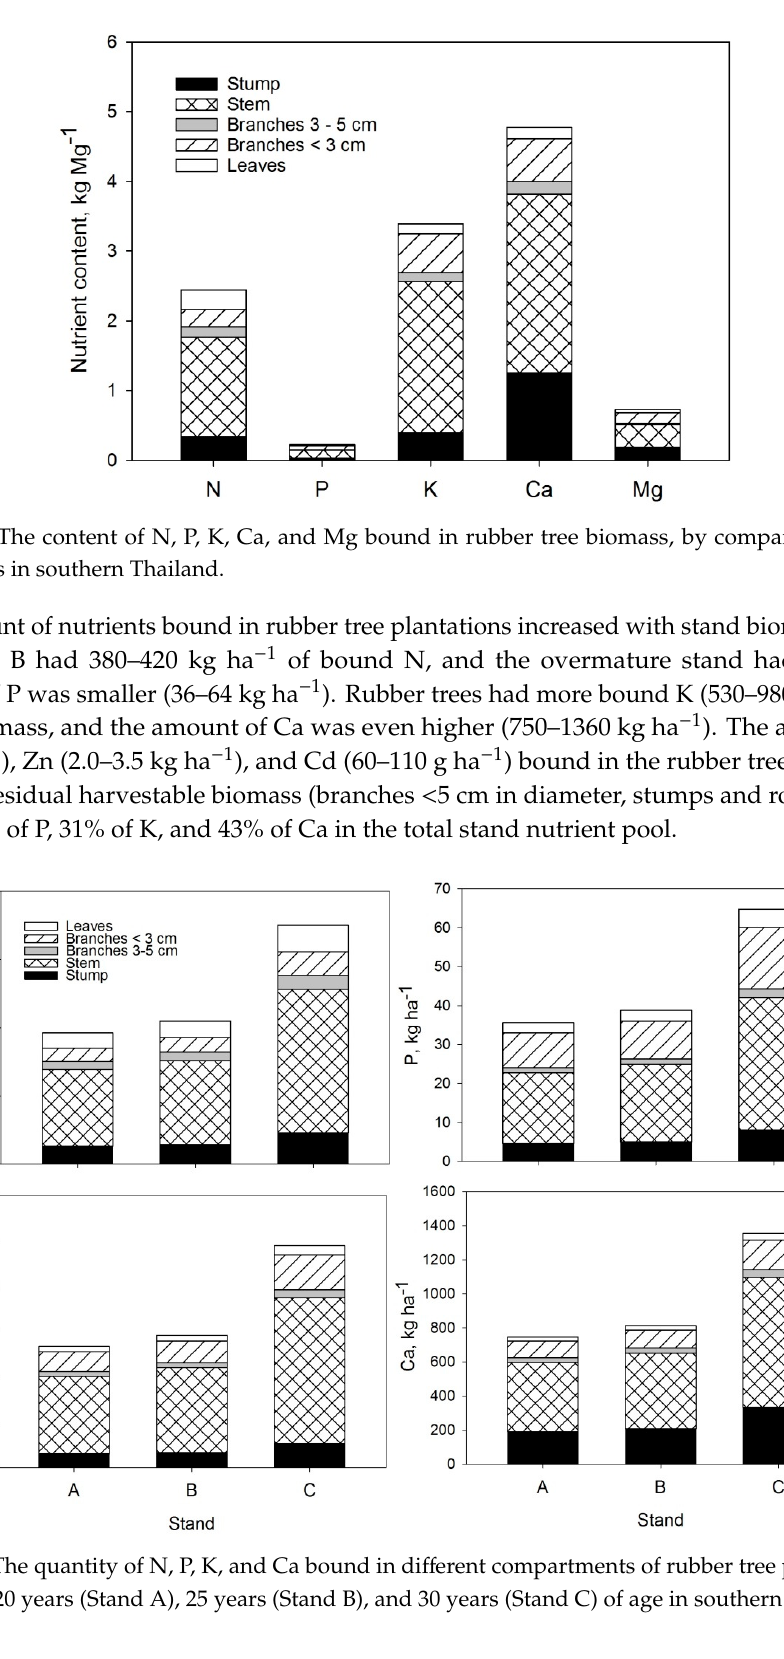
Figure 3. The amount of carbon (C) bound in different compartments of rubber tree plantations that were 20 years (stand A), 25 years (stand B), and 30 years (stand C) of age.